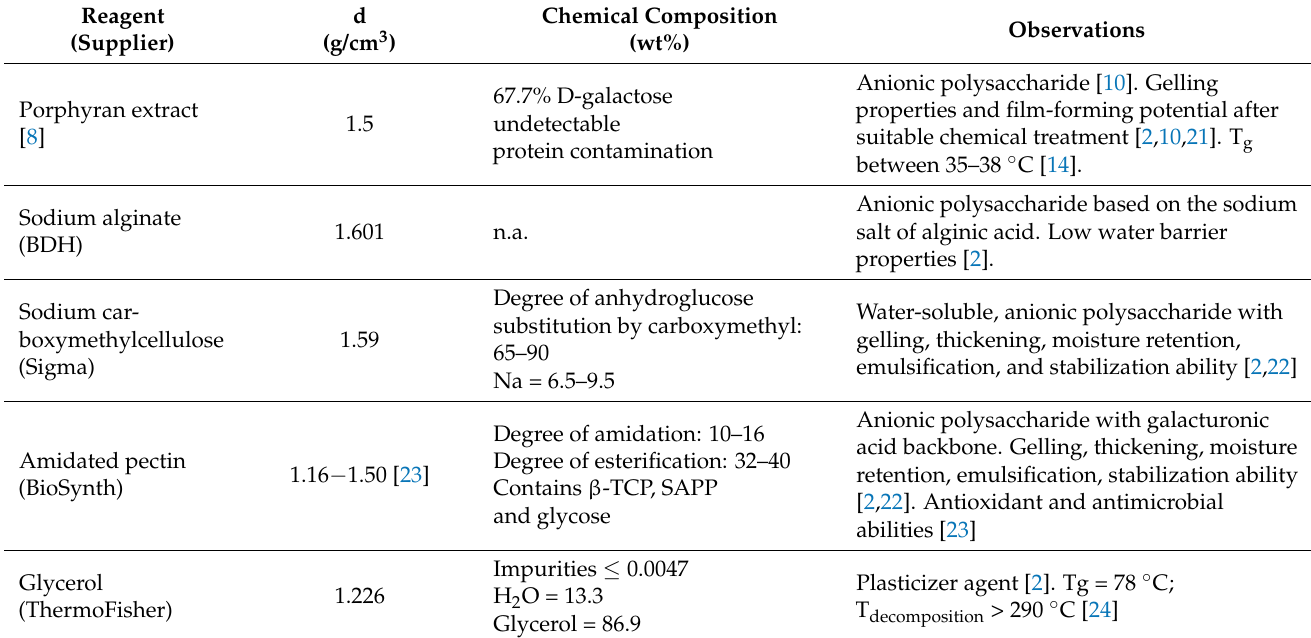
Table 1. Reagents used in the filmogenic solutions (according to supplier, except when mentioned). All reagents were food-grade.